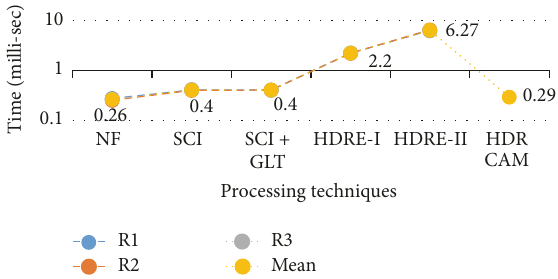
Figure 25: Processing time per pixel in range image.